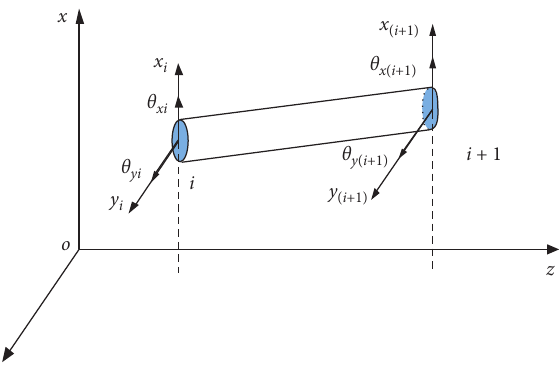
Figure 2: Schematic diagram of an elastic beam